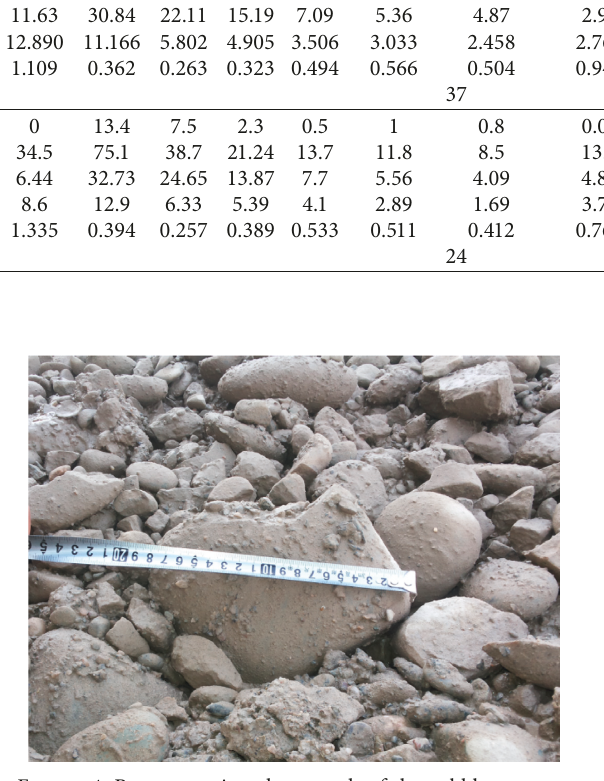
Figure 4: Representative photograph of the cobble stratum.